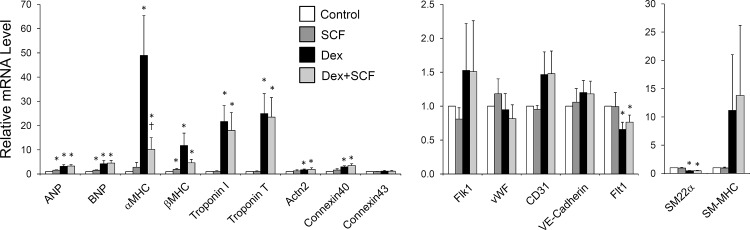
The effect of c-kit activation on cardiac differentiation of CPCs.Murine c-kit+ CPCs were induced to differentiate in dexamethasone-containing media as described in Materials and Methods. Cells in the first two groups were incubated in serum reduced media without dexamethasone and treated either with (SCF) or without (Control) SCF. The latter two groups were treated with 10 nM dexamethasone in the presence (Dex+SCF) or absence (Dex) of SCF. The mRNA levels of indicated cardiac markers were assessed by qPCR. *, p<0.05 compared to the Control. †, p<0.05 compared to the Dex only treatment group.